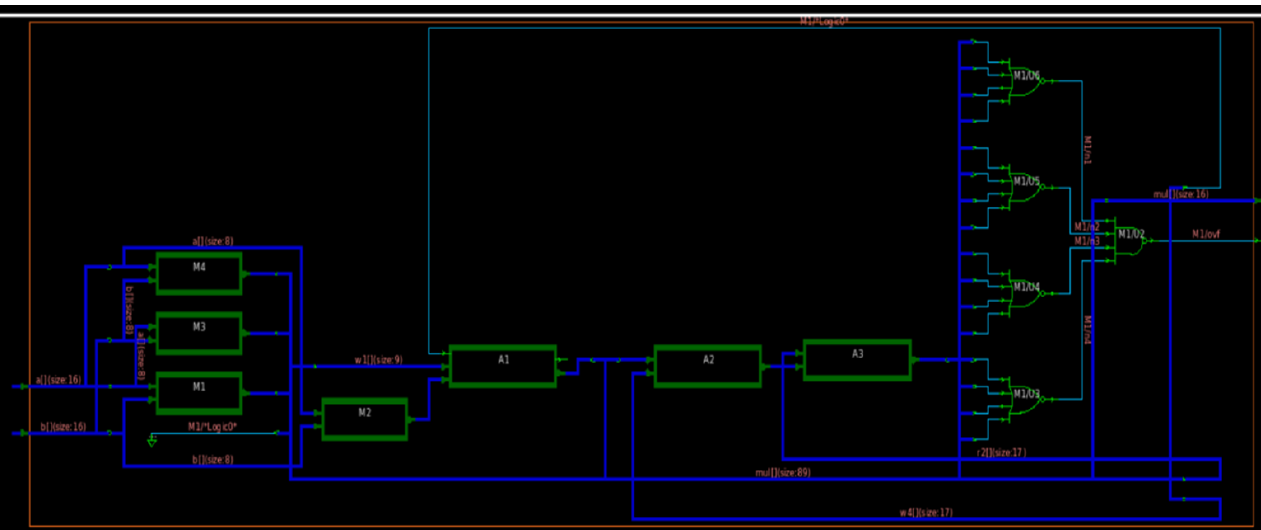
Figure 8. The 16-bit multiplier block diagram.